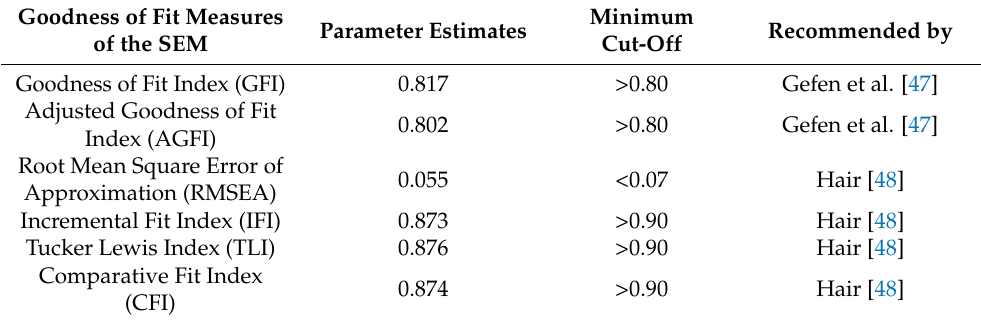
Table 5. The goodness of fit measures.